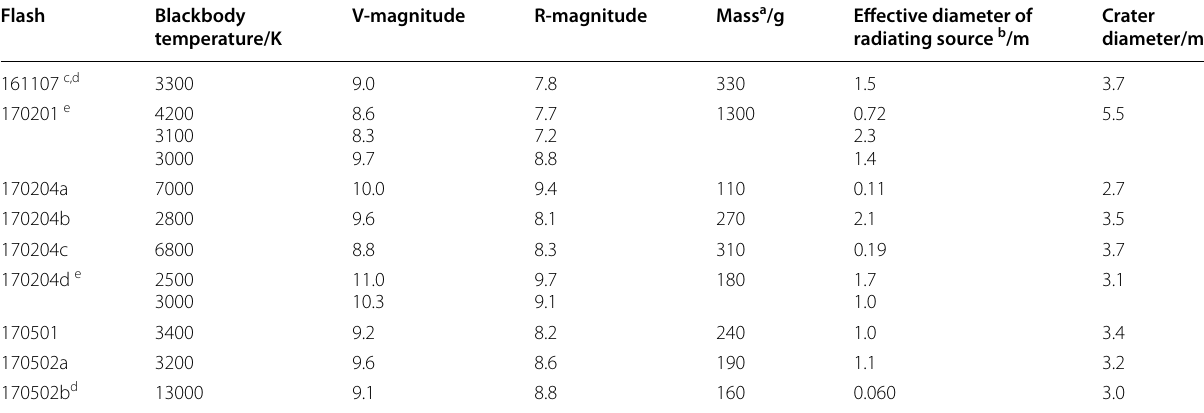
a Assuming meteoroids’ impacts on the lunar surface at 20 km s − 1 b The diameter of a disk with the same area as the cross-section of a radiating source c The 1st-frame might be missed due to the frame drops. See text d The exposure time and frame interval are 16.7 ms for 161107, 12.5 ms for 170502b, and 20.0 ms for the others e Results for multiple successive frames are shown from top to